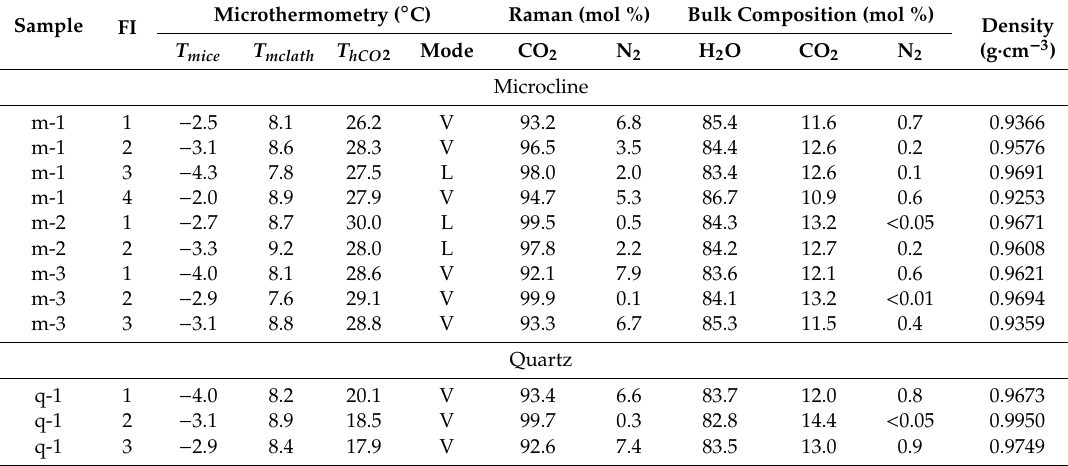
Table 1. Microthermometric results, Raman data, and calculated bulk compositions of selected carbonic-aqueous fluid inclusions.